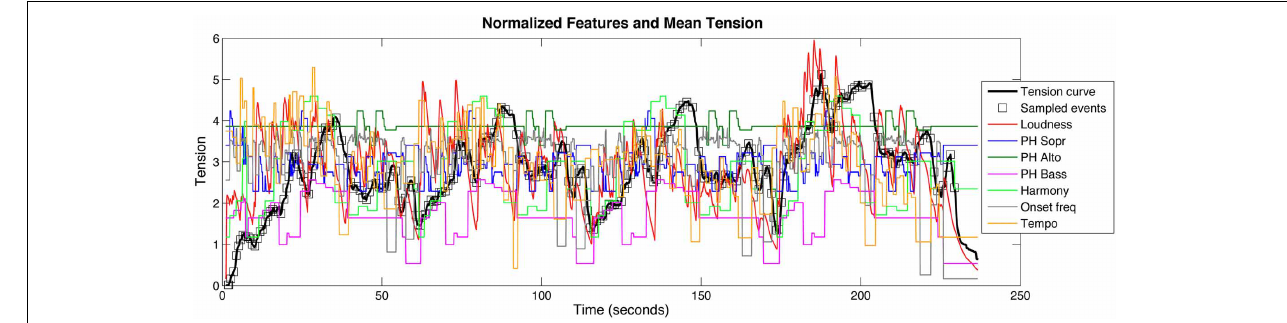
FIGURE 3 | Mean tension response (second trial only) with sampled points at each beat overlaid with all of the feature